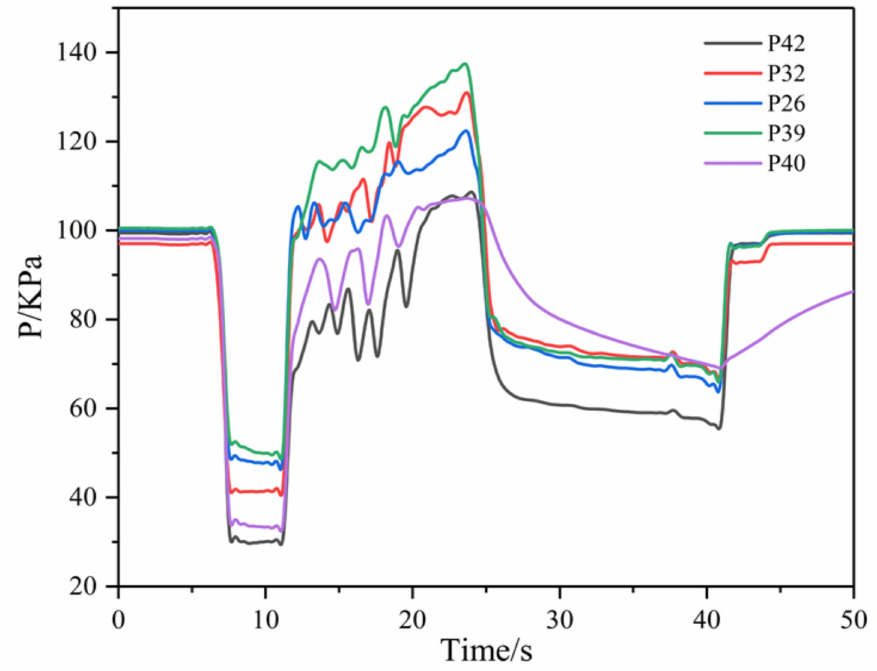
Figure 16. Pressure distribution at the outlet of the combustor.